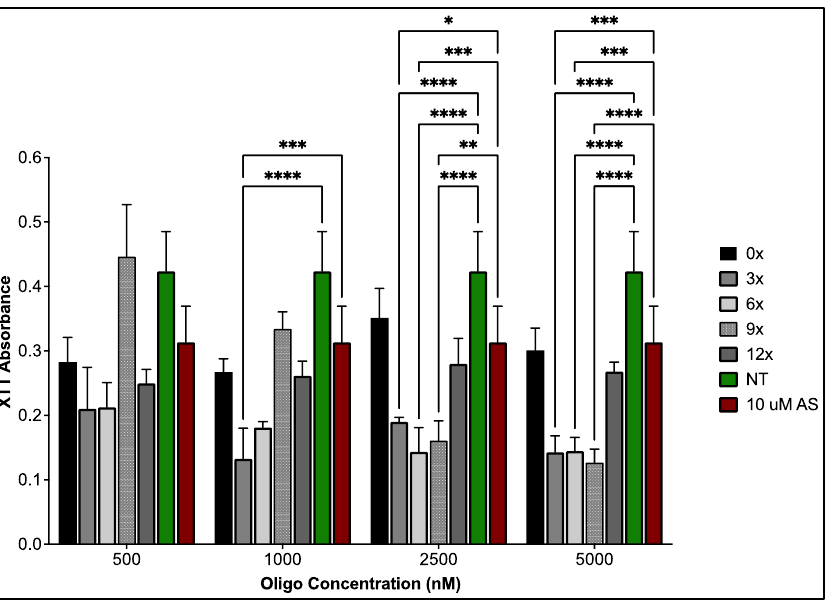
Figure 4. As measured by XTT assay, antiproliferative activity within U87MGs post-treatment with various PEG-AS1411 co-conjugated 4 nm GNPs. The legend shows particular particle syntheses for each concentration of oligonucleotide (AS1411) present within GNP syntheses. Groups treated with 0X represent the maximum amount of gold present within each concentration. NT represents non-treated control groups (media only). * represents p < 0.05, ** represents p < 0.01, *** represents p < 0.001, **** represents p < 0.0001.